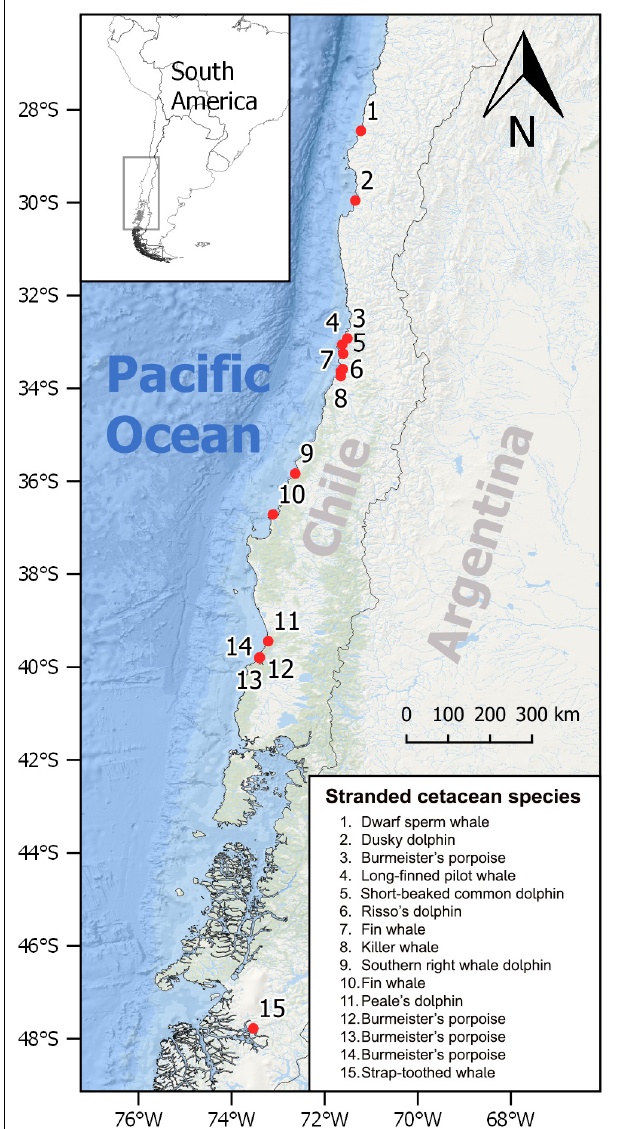
FIGURE 1 | Spatial distribution along the Chilean coast of the cetacean strandings assessed in this